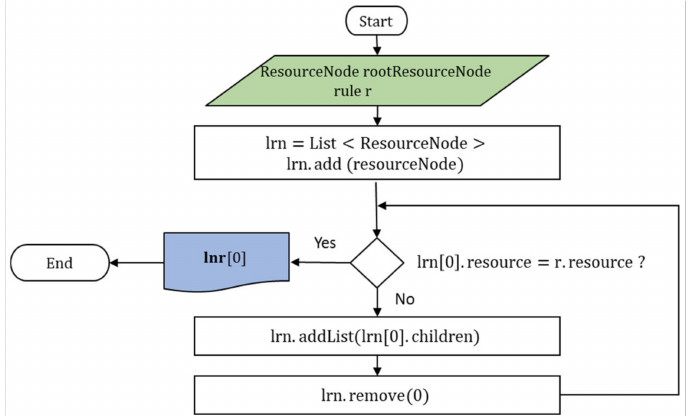
Figure 11. FindResourceNode Algorithm Flow